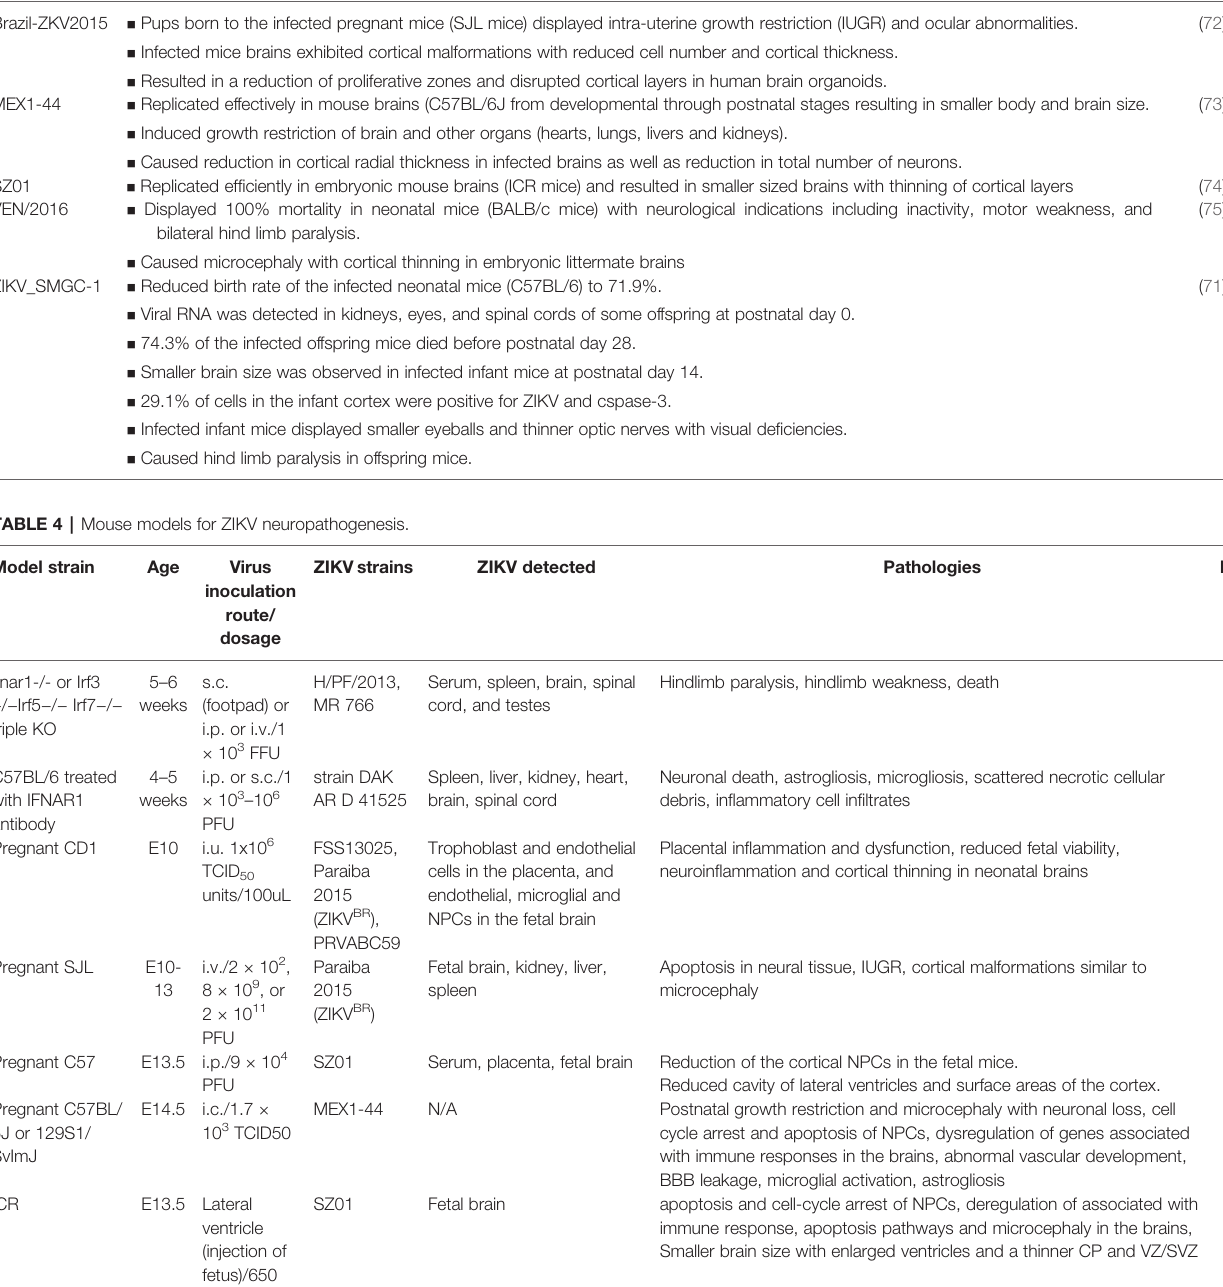
TABLE 3 | ZIKV strains that causes microcephaly and other neurological complications in animal models. ZIKV strains Signs of microcephaly and other neurological